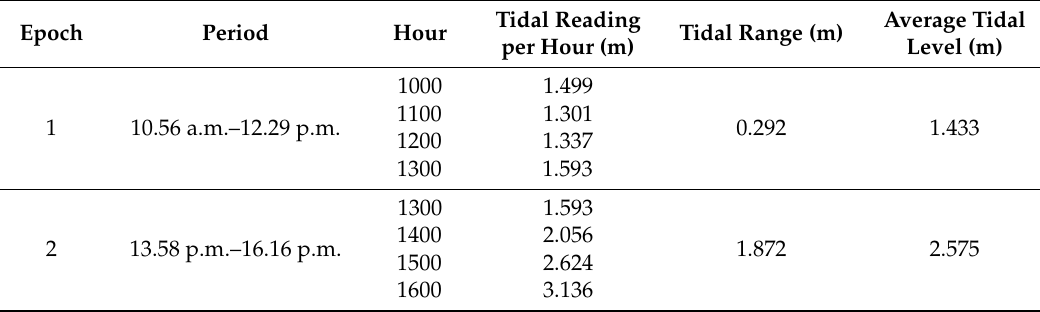
Tidal Reading Tidal Range per Hour (m)